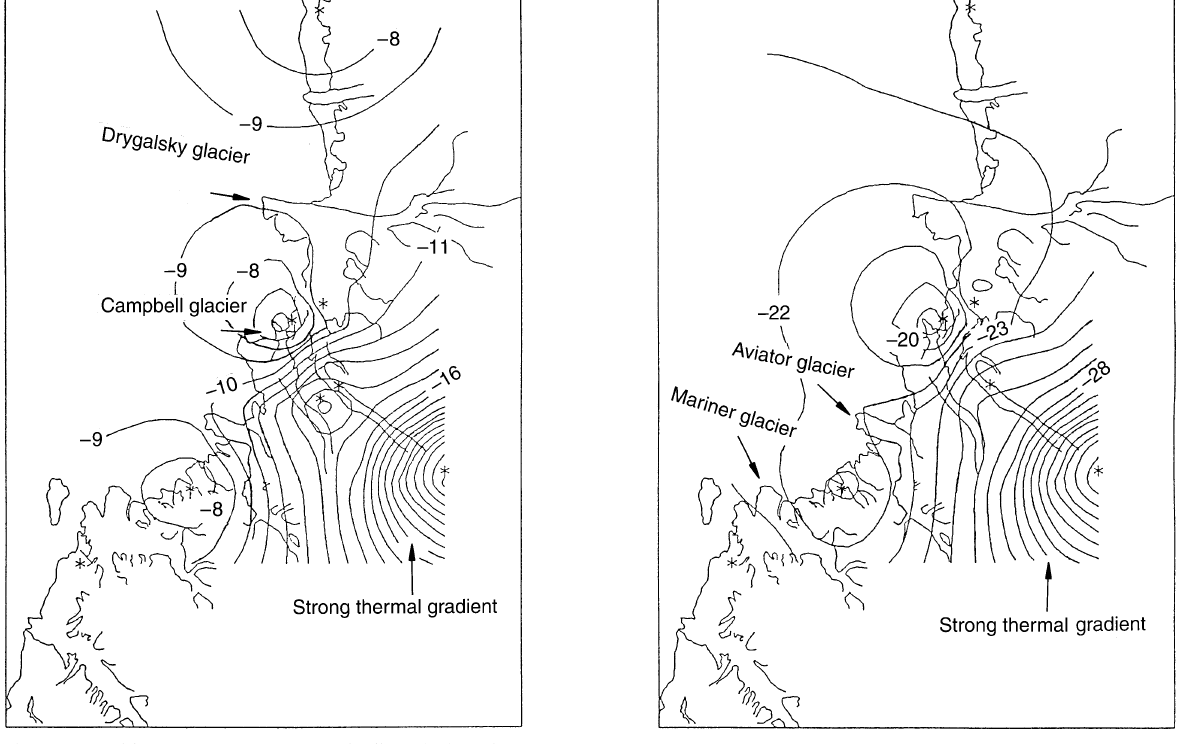
Fig. 2. Monthly average temperature isolines ( ° C), February Fig. 3. Monthly average temperature isolines ( °